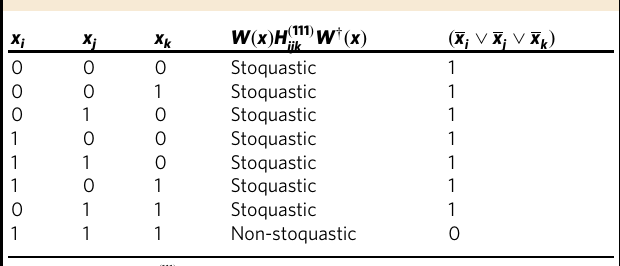
Table 1 Mapping the problem of fi nding a suitable change of basis to the Boolean satis fi ability